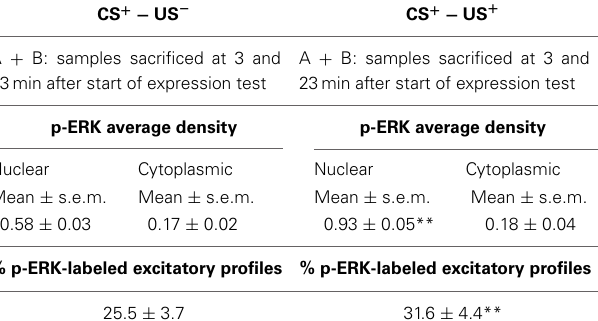
Table 1 | Phospho-ERK average density and percent of p-ERK-labeled excitatory profiles inside the AcbSh of lithium treated (CS + -US + ) and control rats (CS + -US − ) obtained pooling the results from rats sacrificed at 3 and 23min after the beginning of